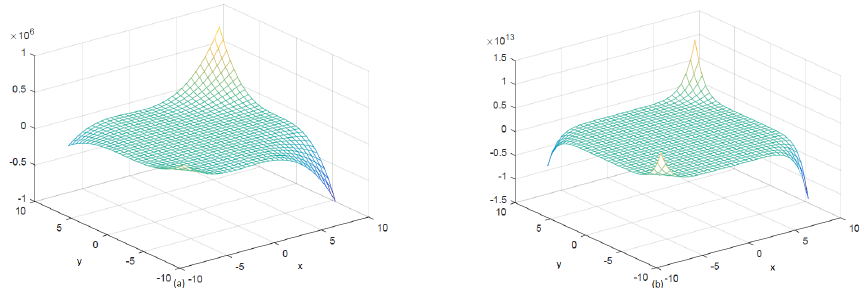
Figure 18: Plotting of (a) M-polynomial and (b) NM-polynomial of Tambjamine